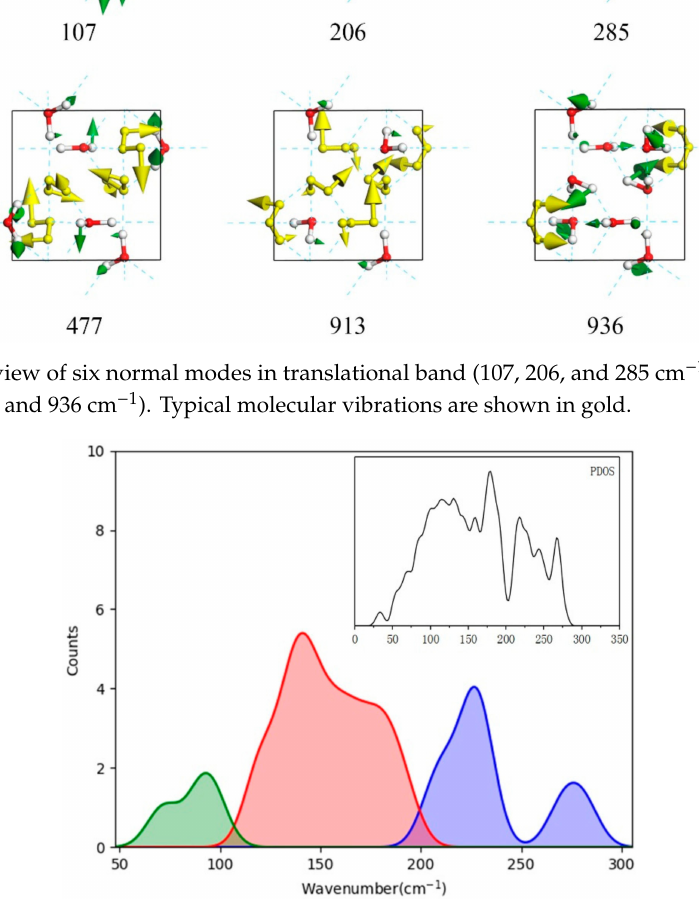
Figure 3. Fitted curves of four-bond modes (blue), two-bond modes (red), and non-H-bond modes (green) of ice XV in translational band. Inset PDOS curve is shown for